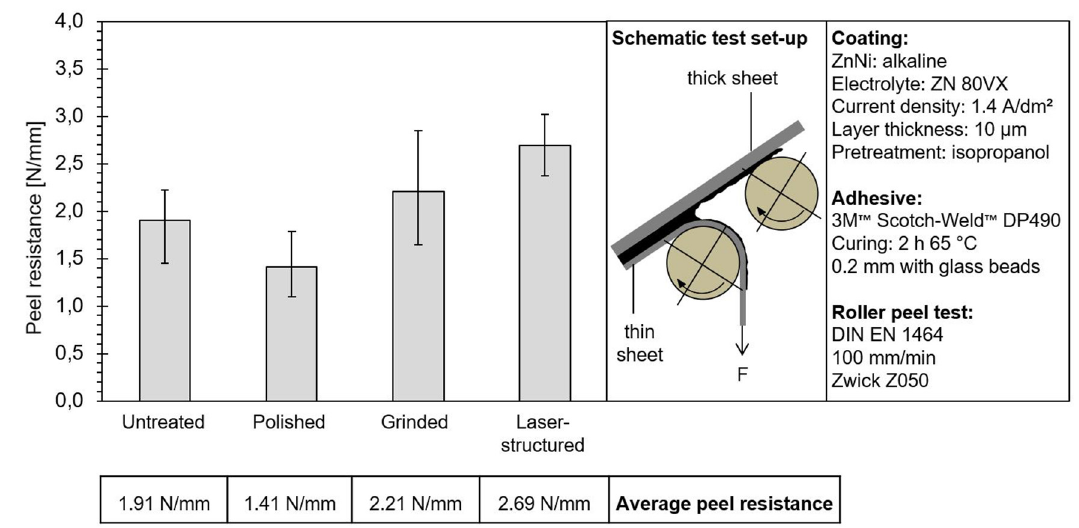
Fig. 7. Peel resistances achieved in roller peel test DIN